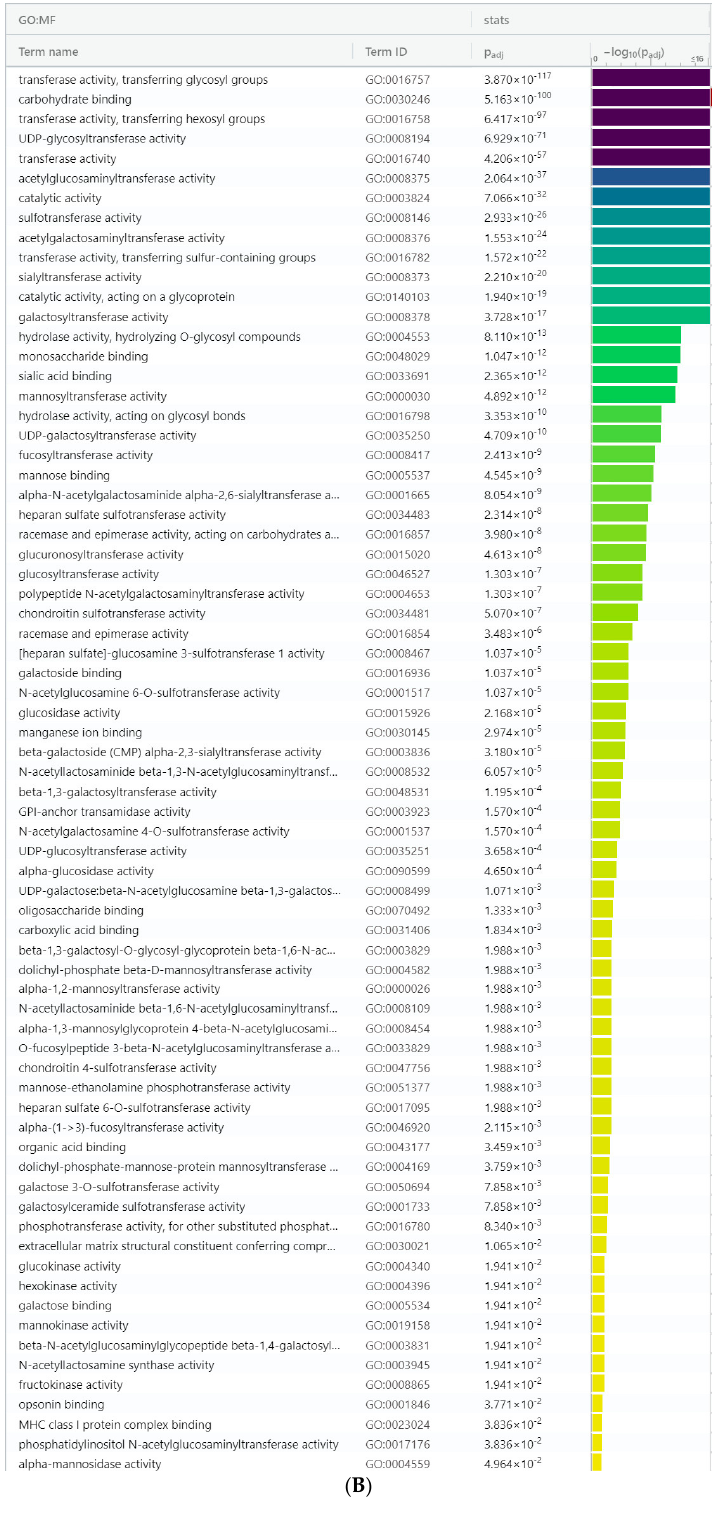
Figure 2. ( A ) Manhattan plot generated from the g:profiler toolset for the functional enrichment analysis using the default signif- icant threshold measures. The x-axis shows the functional terms grouped and color-coded by the respective data sources and the corresponding enrichment p -values in negative log 10 scale are illustrated on the y-axis. A more detailed result table below the image, highlights the manually selected top ranking 10 functional enriched terms and corresponding p -values. ( B ) More detailed result of the GO molecular function output generated from the g:Profiler tool highlighting the maximum represented categories among the input list of differentially expressed glycogenes with their corresponding enrichment p -values in negative log 10